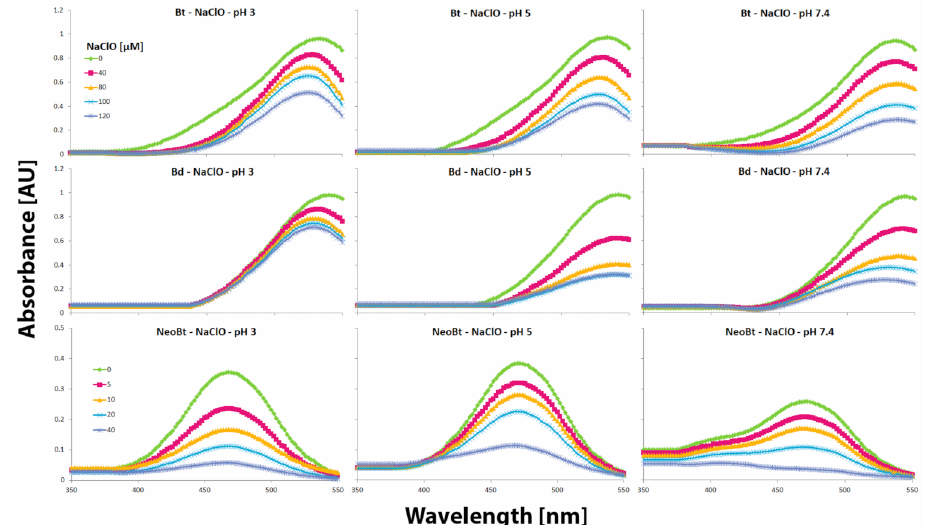
Figure 3. The spectra obtained after 10 min spectrophotometric tracing of betanin 1 (Bt), betanidin 5 (Bd), and neobetanin 7 (NeoBt) reaction progress induced by